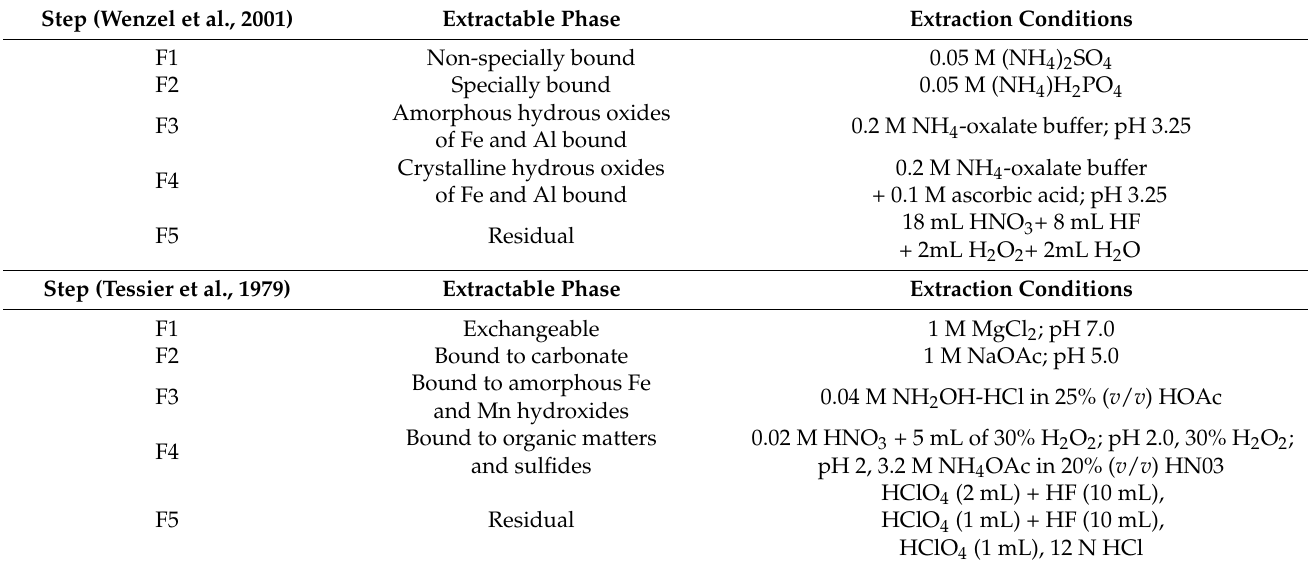
Table A1. Extraction procedures of two sequential extraction